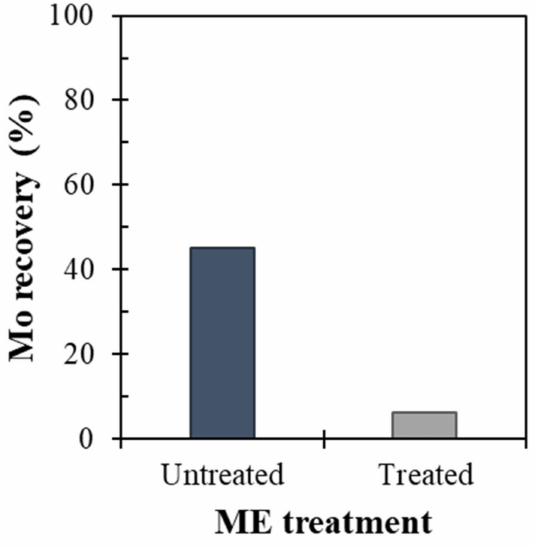
Figure 4. Effect of ME treatment on the floatability of molybdenite. Note that ME treatment was and 1 L/min air introduction. conducted with 10 mM Fe 2 + /H 2 PO − 4